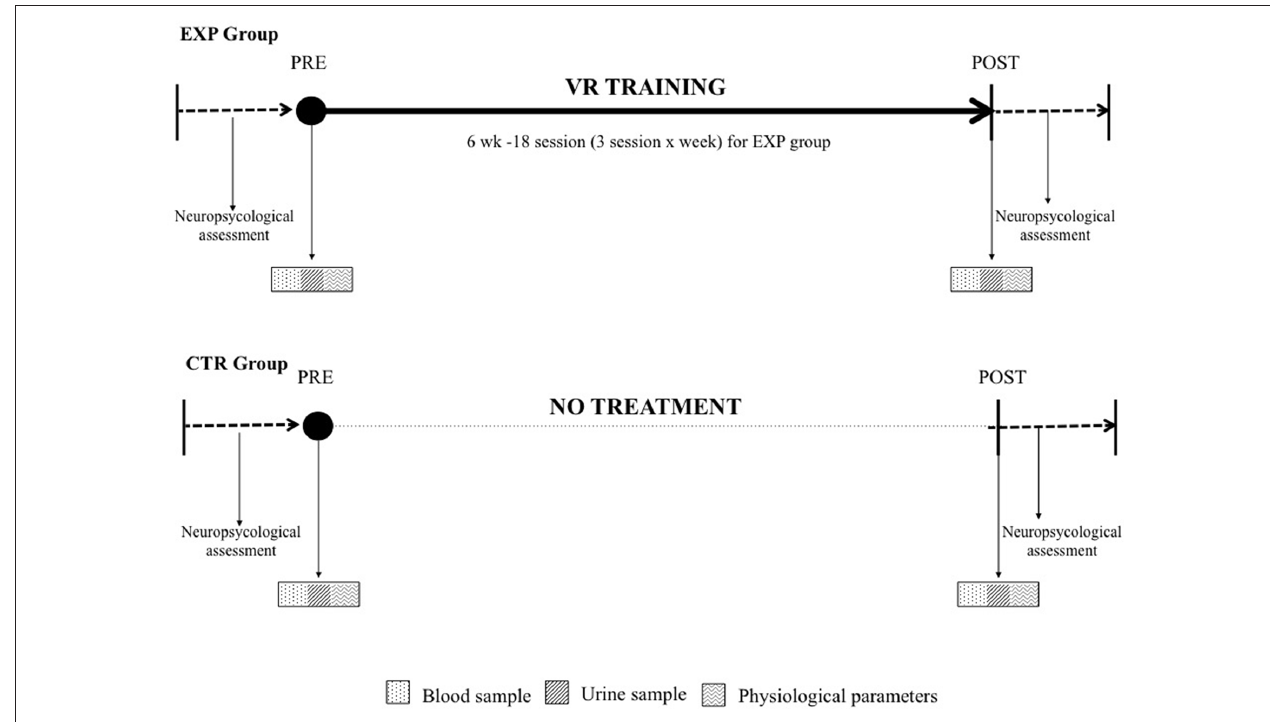
FIGURE 1 | Experimental protocol of the virtual reality (VR)-based training program. The training consisted of 18 sessions for six consecutive weeks, with three sessions per week. All the assessments were carried out at baseline (PRE) and after (POST) 6 weeks for both groups (EXP—see upper part of the figure and CTR—lower part of the